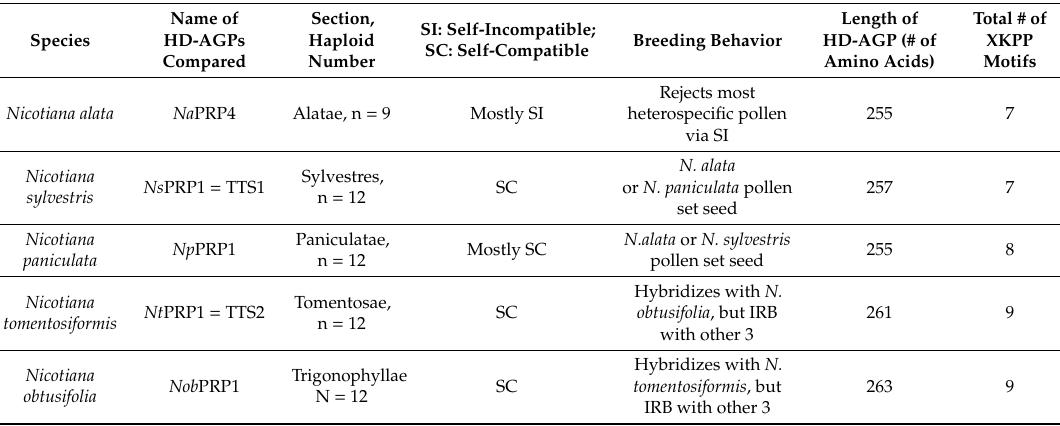
Table 4. Summary of breeding behavior of Nicotiana species and attributes of their